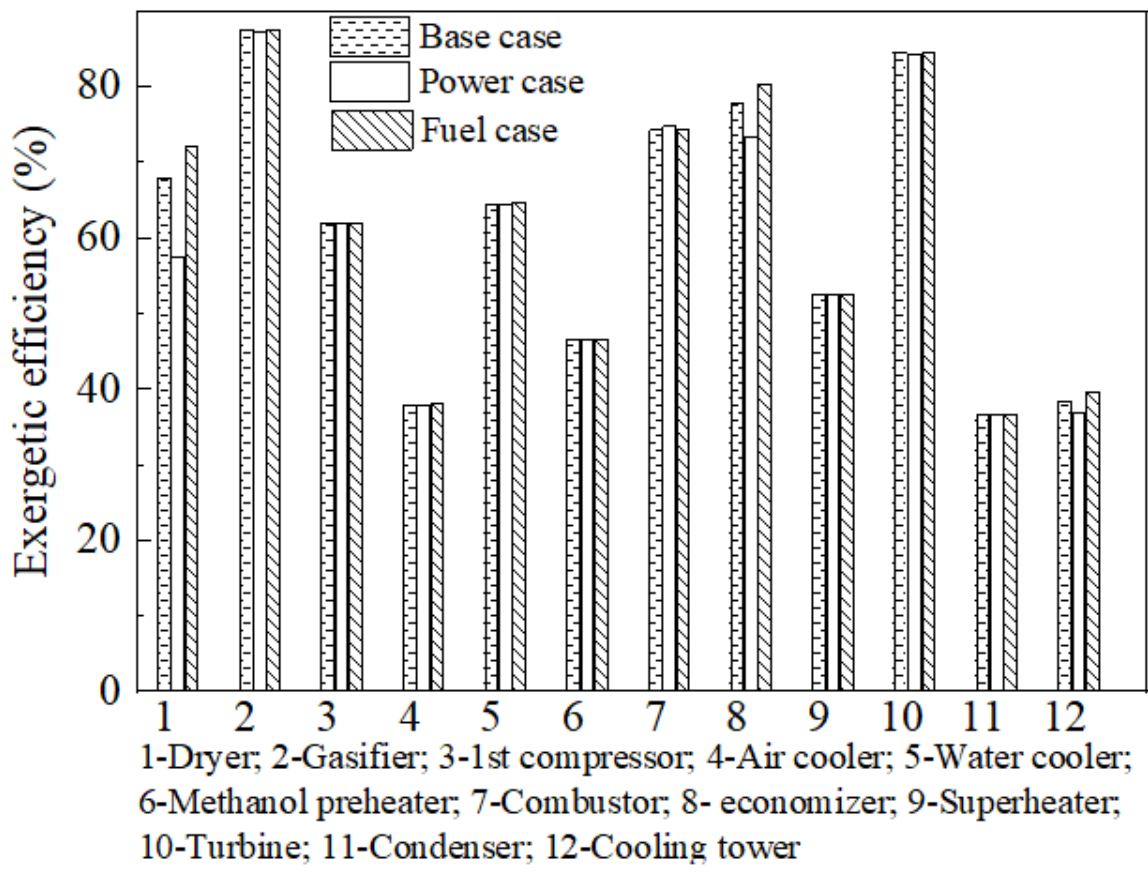
Figure 4. Exergetic efficiency of the main units for each